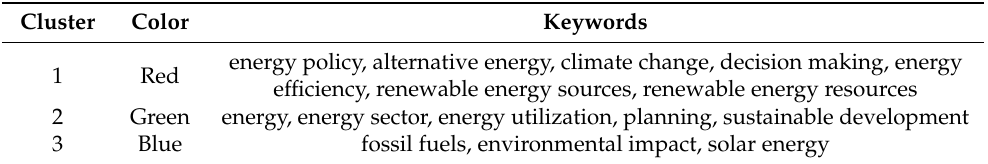
Table 10. Clusters of keyword co-occurrences in Figure 10 for Scopus Query